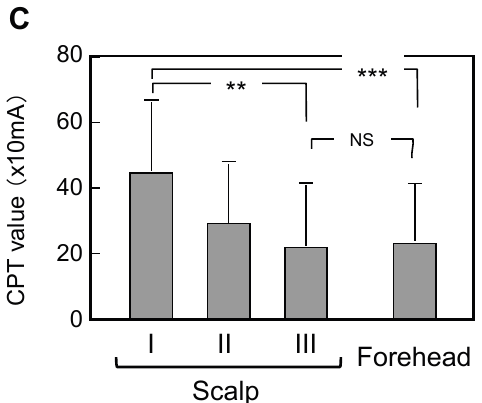
Figure 4. Comparison of measured data for CPT for 2000 Hz ( A ), 250 Hz ( B ), and 5 Hz ( C ) between scalps with different skin symptoms and the forehead. Each column indicates the average and the bars show standard deviation. * indicates p < 0.05, ** indicates p < 0.01 and *** indicates p < 0.001 as a significant difference. NS indicates as no significant